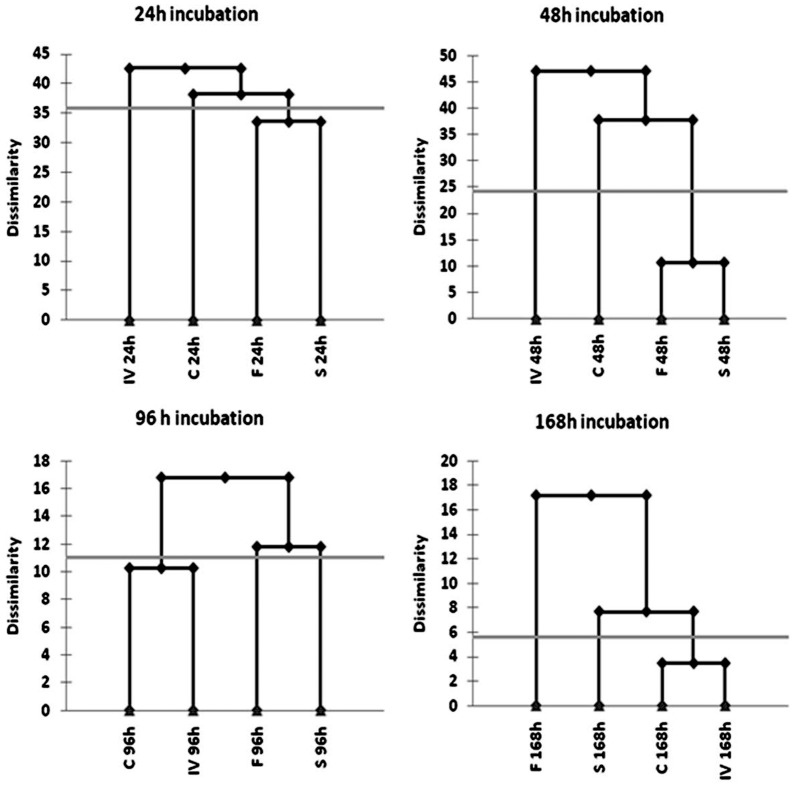
Hierarchical clustering based on the carbon source utilization profiles after 24, 48, 96 and 168 h of incubation of cultures started from conidia isolated from the four trophic phases (in vivo, sapro, flask and chemo).The gray horizontal lines indicate distance measures of the carbon source utilization profiles and describe the metabolic similarity between the phases at different incubation intervals. The dendrograms show the progressive grouping of the data (and therefore the higher or lower similarity between trophic phases) along the microplates incubation period (24, 48, 96 and 168 h).